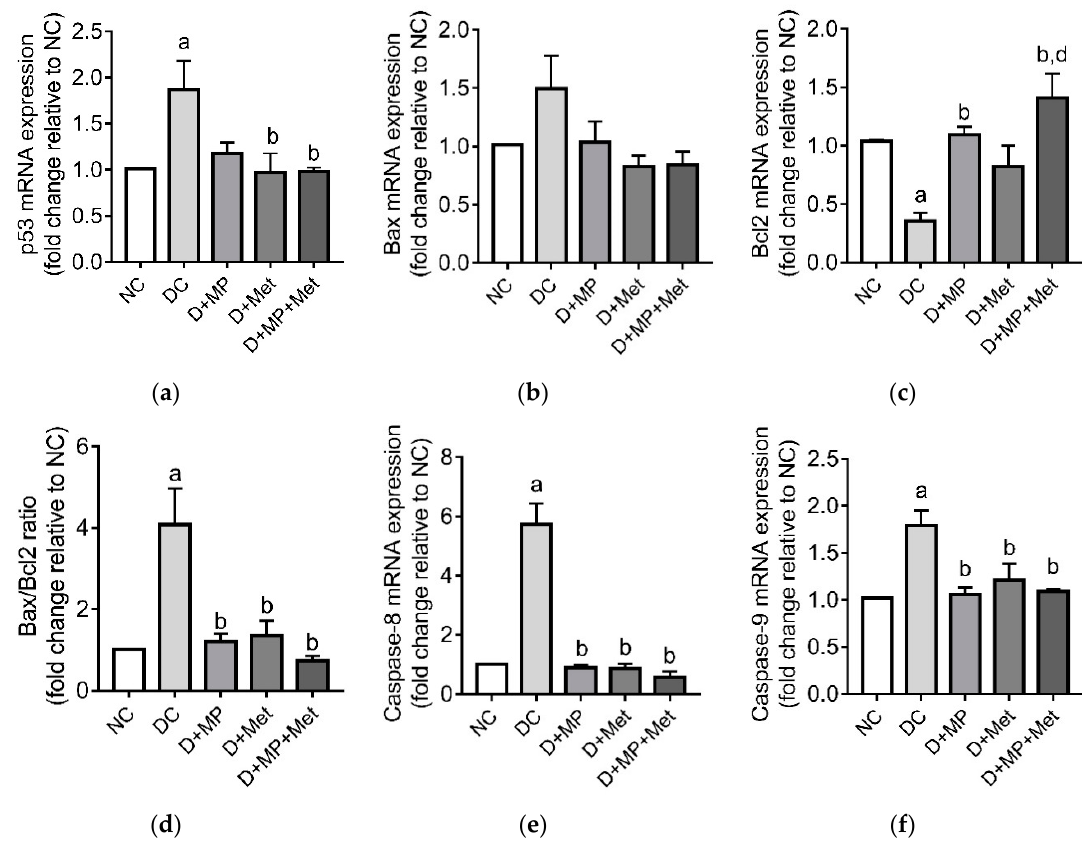
Figure 7. The effect of Malaysian propolis, metformin and their combination on testicular mRNA expressions of ( a ) p53, ( b ) Bax, ( c ) Bcl ‐ 2, ( d ) Bax/Bcl ‐ 2 ratio, ( e ) caspase ‐ 8 and ( f ) caspase ‐ 9, in diabetic rats. Values are mean ± SD, n = 6. a p < 0.05 versus NC, b p < 0.05 versus DC, d p < 0.05 versus D+Met